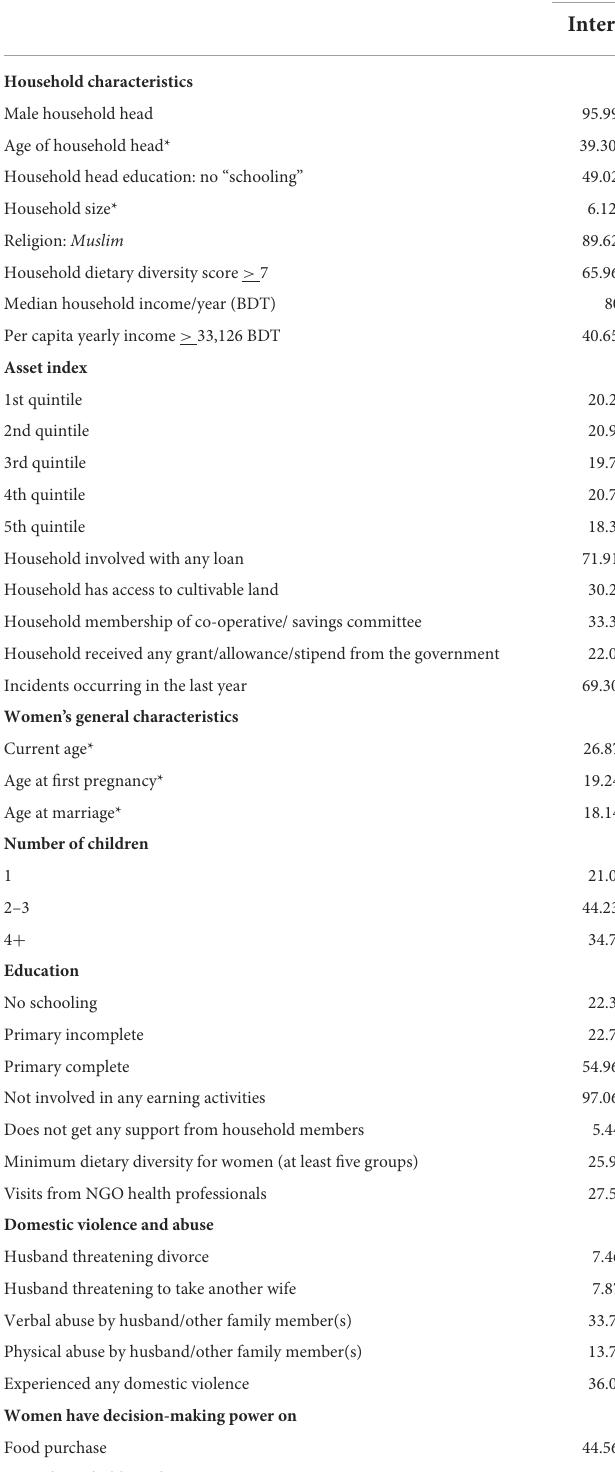
TABLE 1 Household and women’s general characteristics. Indicators, % ( n ) Baseline Endline Intervention Control Intervention